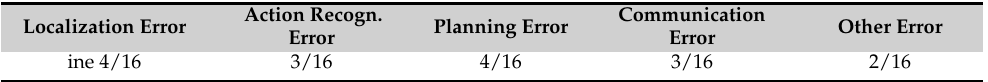
Table 3. Error justification analysis from the situations where the robot failed to execute the scenario. Action Recogn. Localization Error